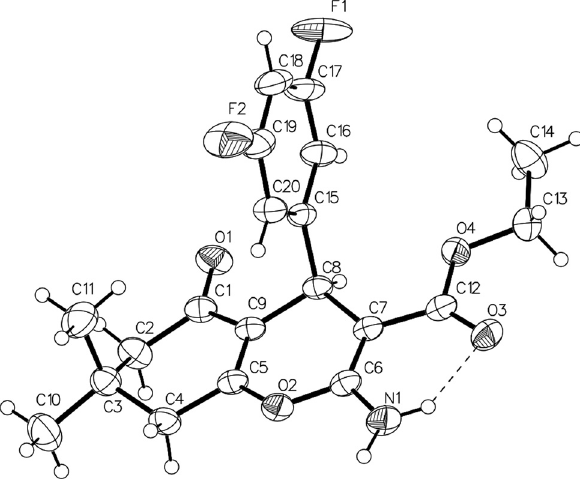
Table  : Data collection and